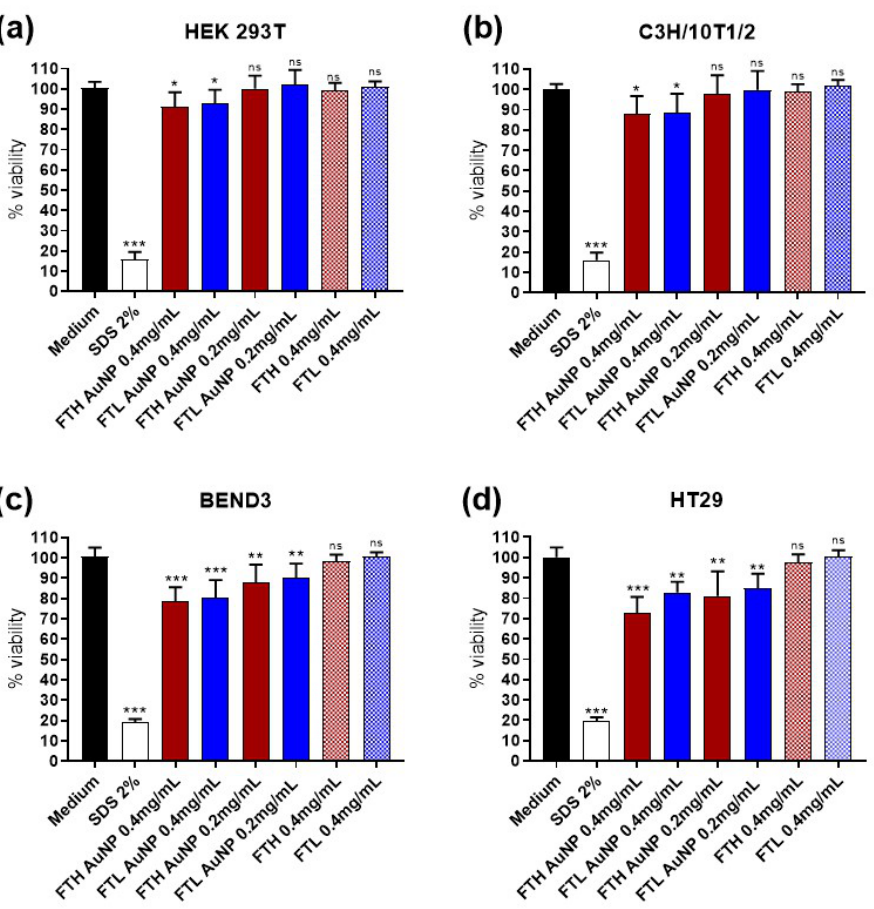
Figure 5. Cell viability after incubation with ferritin Au-NP compared to apoferritin. ( a ) HEK 293T cell line, ( b ) C3H/10T1/2 cell lines, ( c ) BEND3 cell lines, and ( d ) HT29 cell lines (mean ± SEM; n = 9;